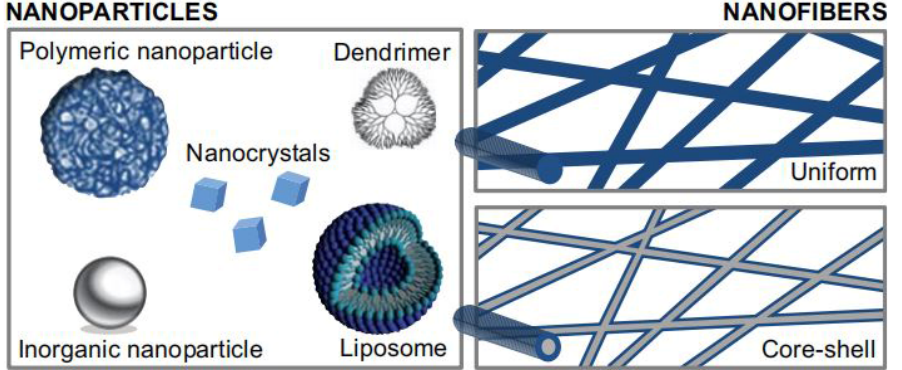
Figure 4. Various forms of nanomedicines. Reprinted/adapted with permission from Ref. [42]. 2015, Kristl, J.